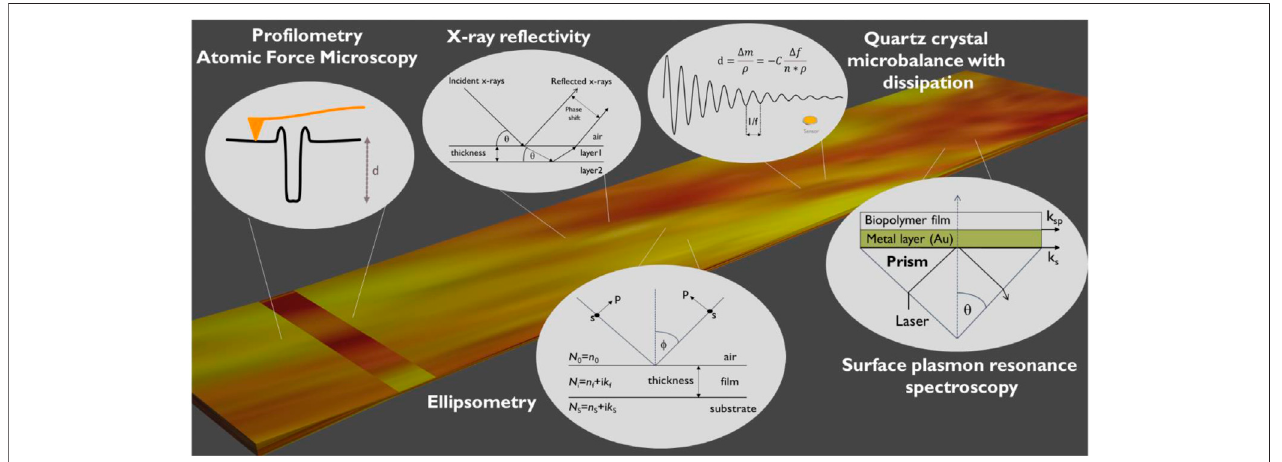
FIGURE 3 | Overview of commonly employed techniques for thickness determination of biopolymer thin fi